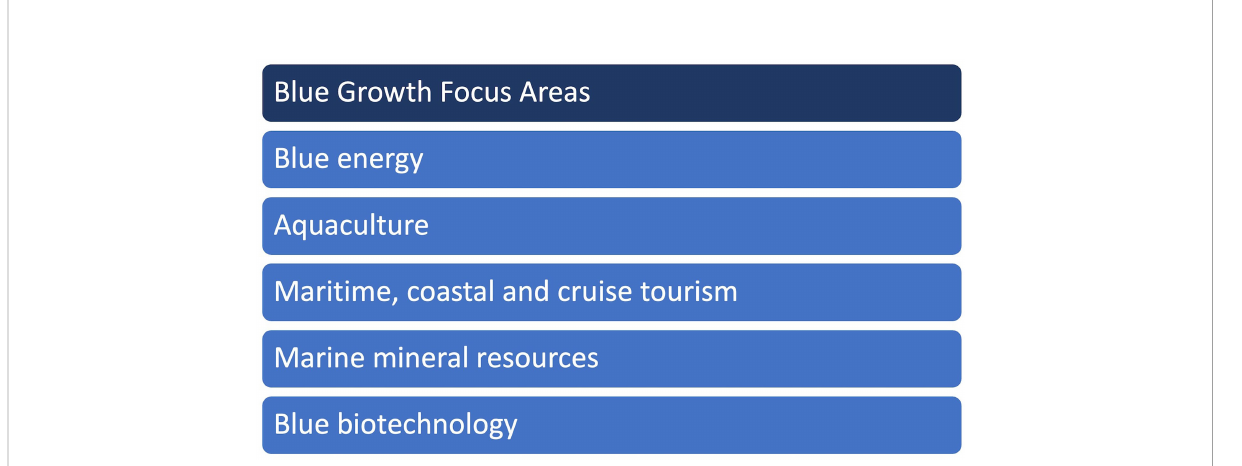
FIGURE 4 Blue Growth Strategy Focus Areas. The ‘ Blue Economy ’ was considered as the sixth Focus Area since most countries have speci fi c measures for the Blue Economy in their National Ocean Strategies, which are not included in the Focus Areas of the Blue Growth Strategy. Source: Created by the